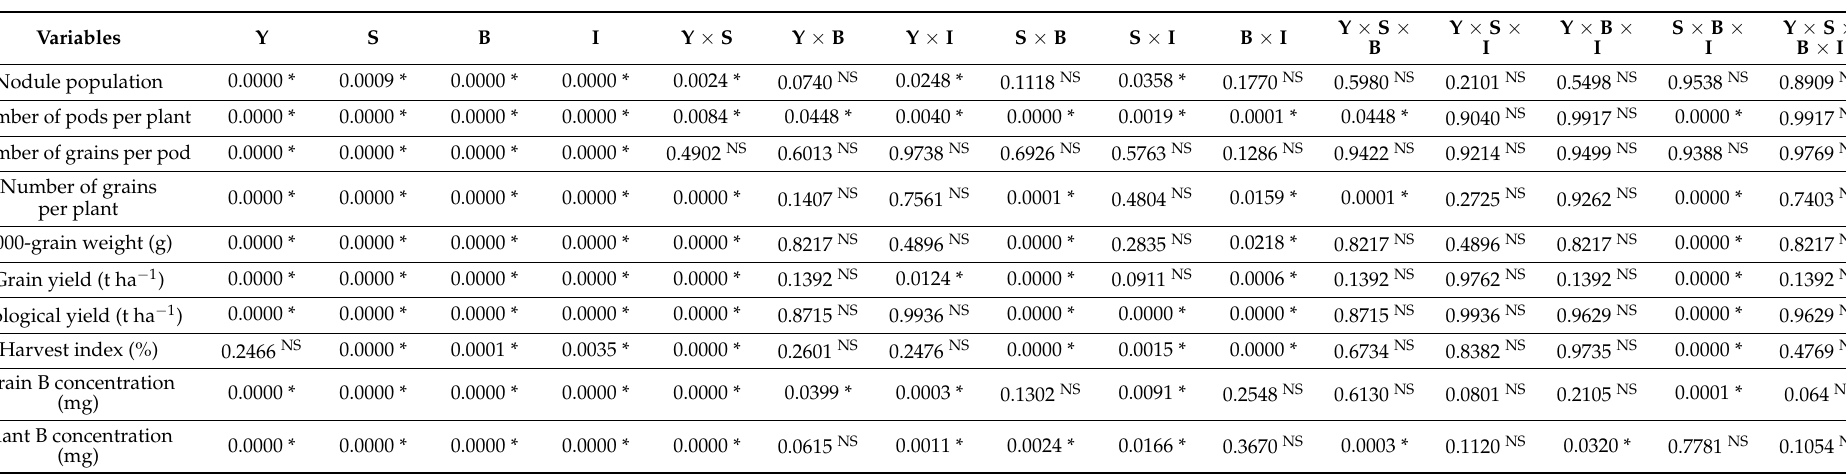
Table 2. Analysis of variance ( p values) of individual and interactive effects of year, location, BTB ( Bacillus sp. MN54) inoculation and boron nutrition for growth and yield-related traits of desi